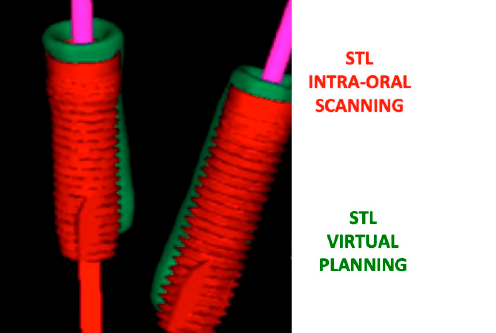
Figure 1. The 3D spatial software reconstruction of dental implant screws in pre-surgical virtual planning vs actual clinical position after the surgical procedure.